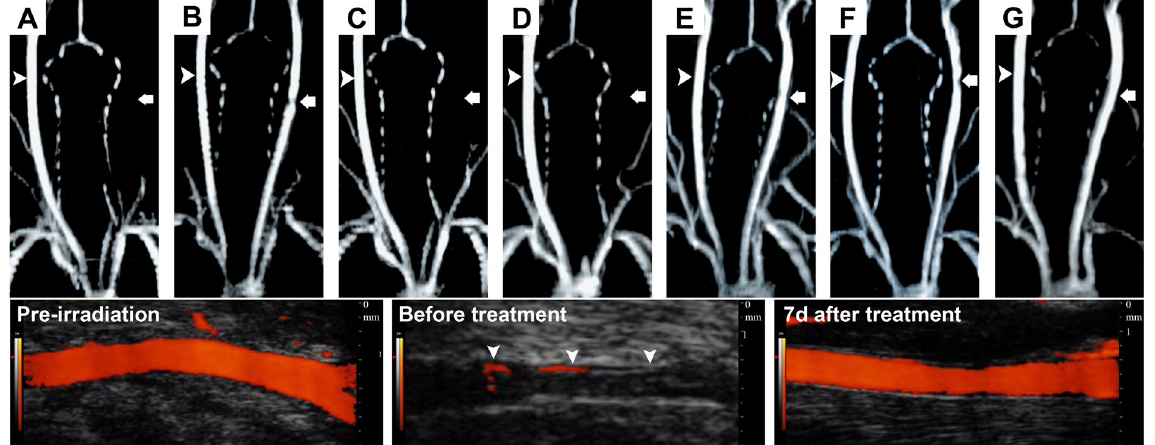
Figure 3. MR angiographic findings at 7d in each treatment group. The left common carotid artery (CCA) is occluded in groups A, C and D. However, left CCA shows some degree of stenosis in groups B, E, and F. In group G, there is complete recanalization with minimal residual stenosis. The carotid ultrasound examination demonstrates the change in group G which shows the normal CCA before LED irradiation (pre-irradiation), after irradiation, complete occlusion of CCA before rt-PA treatment (before treatment, arrowheads indicate vessel wall), and recanalization of occluded CCA at 7d after rt-PA treatment (7d after treatment). In A-G, the arrow indicates the injured left CCA, and arrowhead indicates the normal right